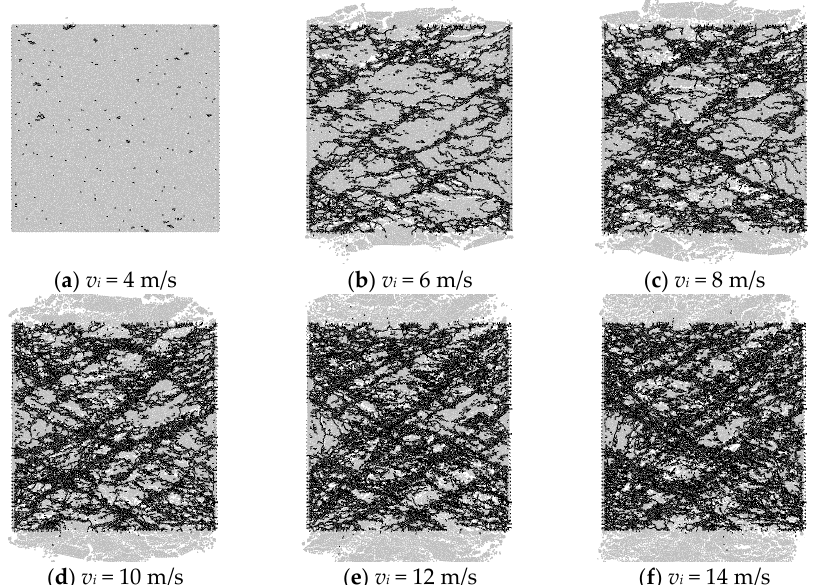
Figure 8. Failure patterns of specimens at different impact speeds without pre-stress.